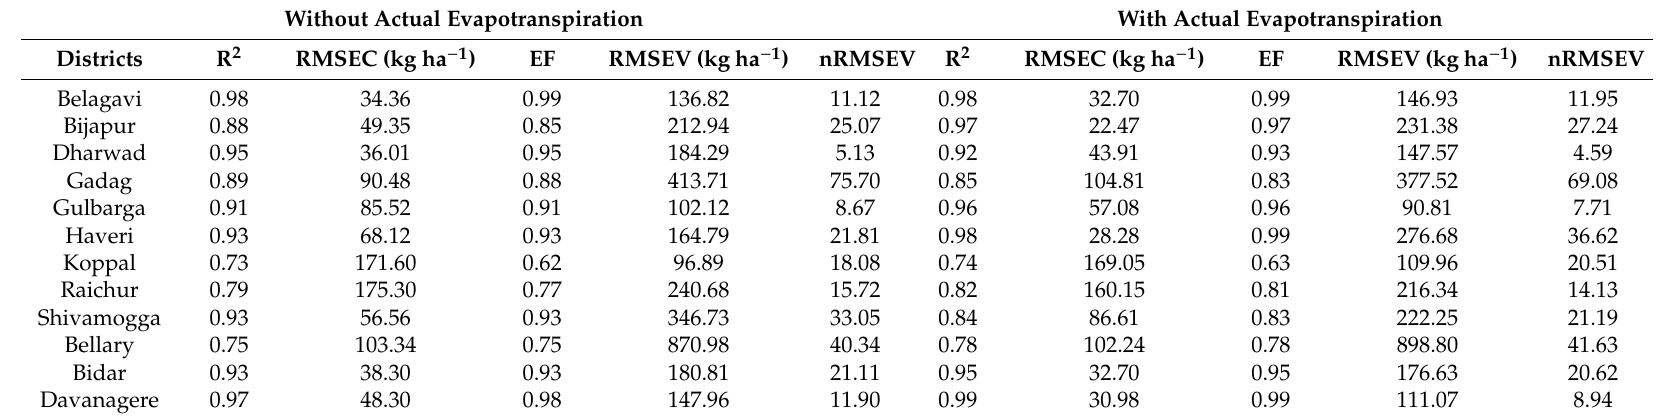
Table 4. Quantitative measures obtained for sorghum yield prediction of Karnataka using